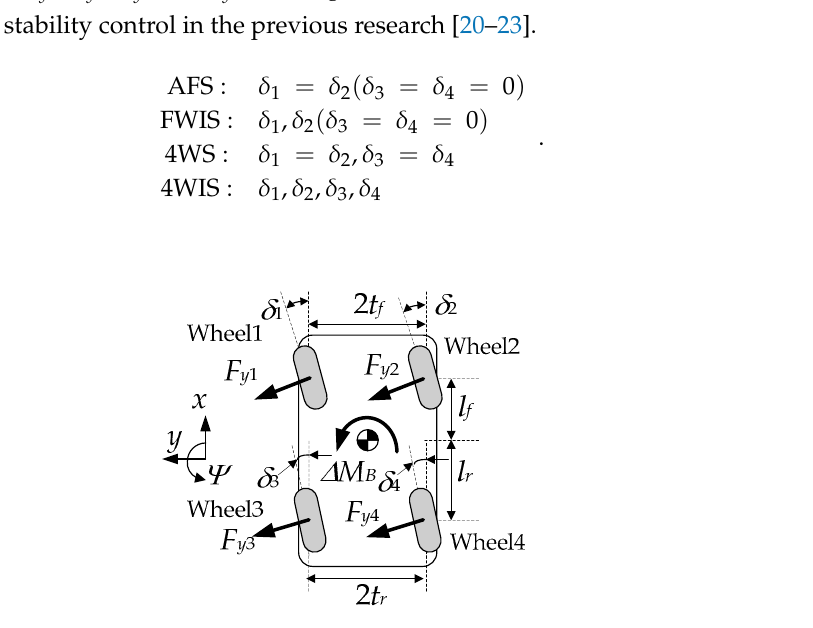
Figure 2. Free-body diagram of the tire forces and the control yaw moment.